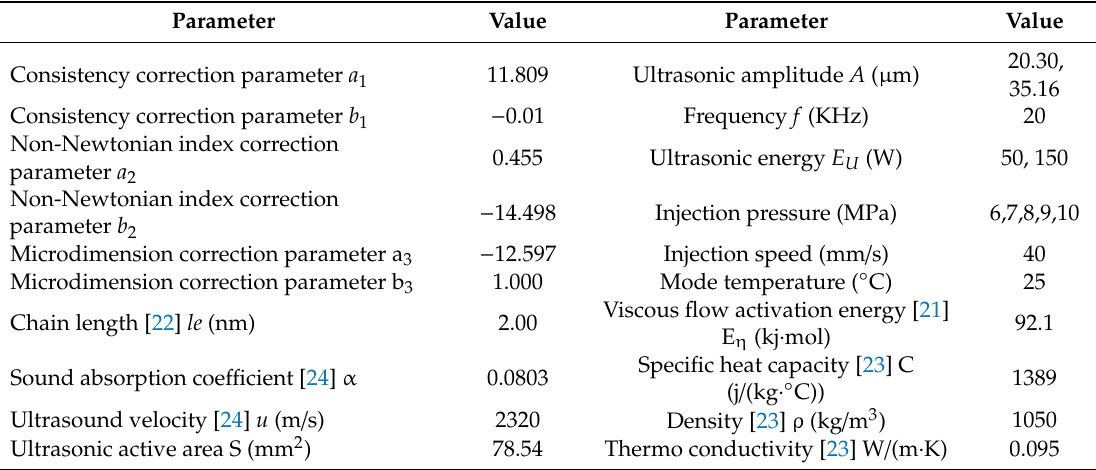
Table 4. MU viscosity model parameters and rheological parameters for